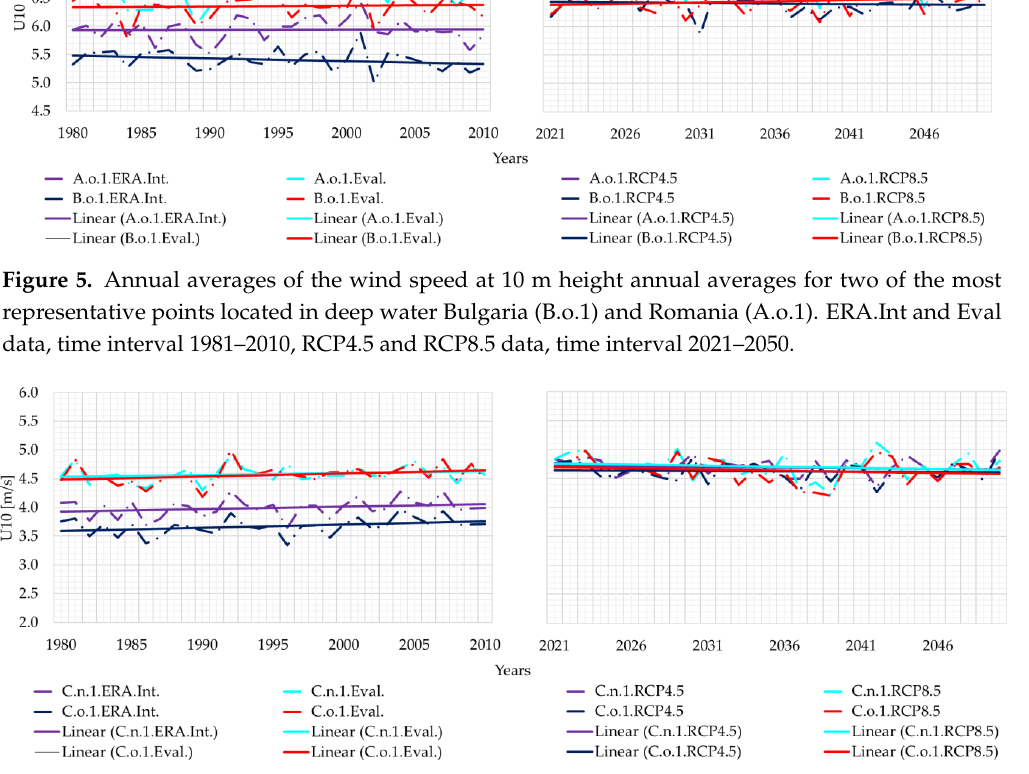
Figure 6. Annual averages of the wind speed at 10 m height for two of the most representative points located in shallow water (C.n.1) and in deep water (C.o.1) of Turkey. ERA.Int and Eval data, time interval 1981–2010, RCP4.5 and RCP8.5 data, time interval 2021–2050.